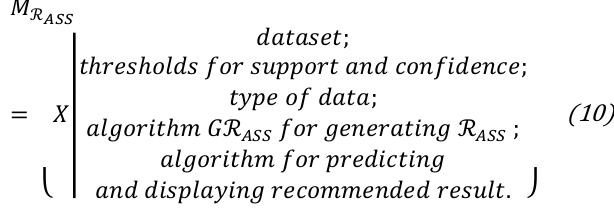
Algorithm 1 . IRG (Implication Rules